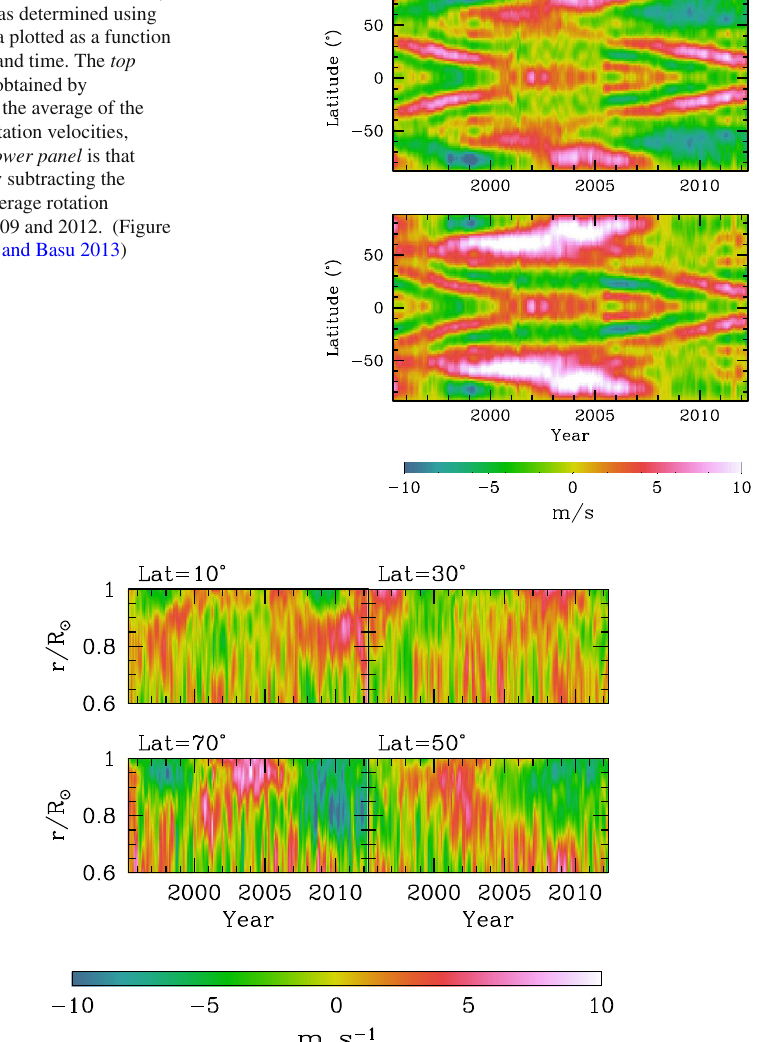
Fig. 34 The zonal flow velocity plotted as a function of radius and time for a few latitudes. Results were obtained using data obtained by the GONG project. (Figure from Antia and Basu 2013)